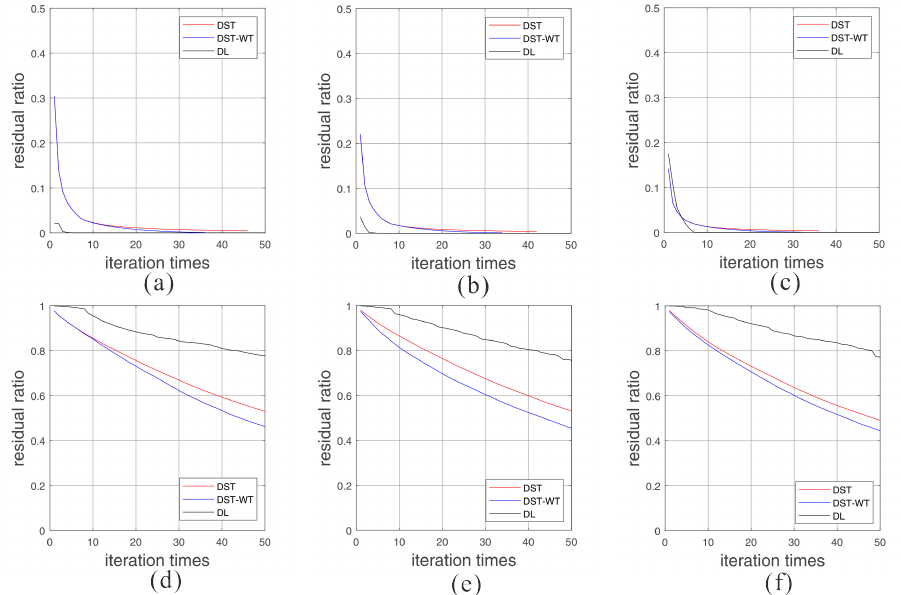
Figure 8. The convergent performances with three dictionaries of different segments with locations from far, middle and near offset. ( a – c ) are the convergence performance of intercepted raw noise free signals. ( d – f ) are the convergence performance of four kinds of added noise with the same locations. In this figure, DST means discrete sine transform dictionary, DST-WT represents the merged dictionary of discrete sine transform and wavelet transform, and DL represents the dictionary generated by learning